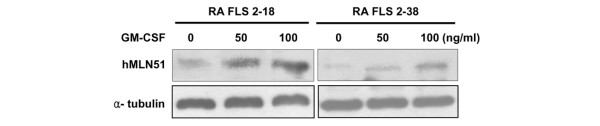
Western blot analysis of hMLN51 in RA fibroblast-like synoviocytes (FLSs) treated with GM-CSF. Rheumatoid arthritis (RA) FLSs (2–18 and 2–38) isolated from the two patients with RA were seeded at 5 × 104 cells per well in a six-well plate. FLSs grown in high-glucose DMEM supplemented with 10% FBS were cultured further in the presence of granulocyte – macrophage colony-stimulating factor (GM-CSF) at 0, 50 and 100 ng/ml for 6 hours. Cells were harvested, separated by 10% SDS-PAGE, transferred to a nitrocellulose membrane and then proved with anti-hMLN51 rabbit serum (1:1,000 dilution) and horseradish peroxidase-conjugated anti-rabbit IgG (1:5,000 dilution). This result is representative of three separate experiments.